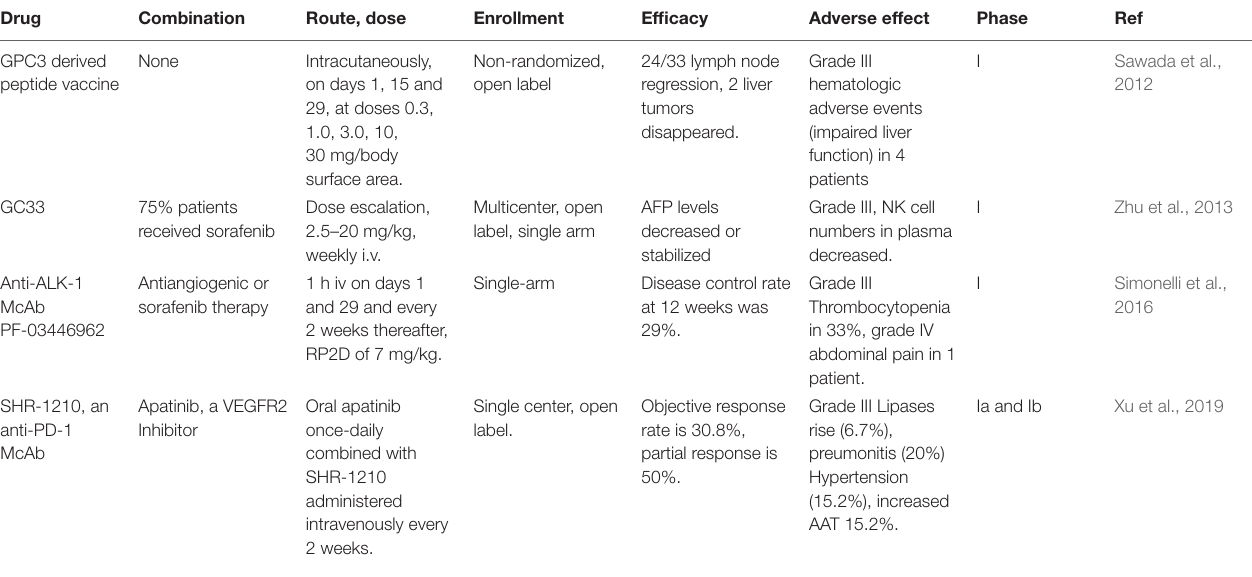
TABLE 5 | Published clinical trials involving GPC3, ALK-1, and PD-1 in HCC